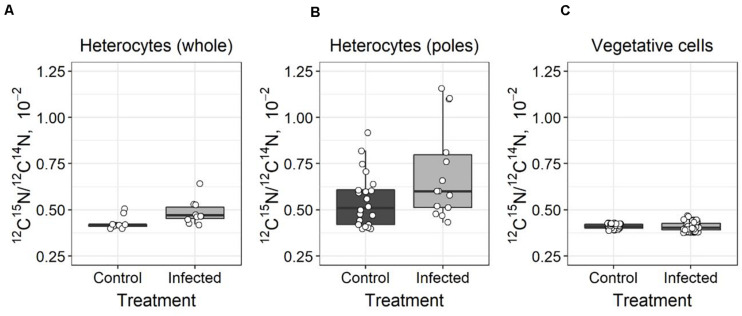
Differences in 15N enrichment in Aphanizomenon flos-aquae strain 2012/KM1/D3 heterocytes (whole cell–A, poles–B) and vegetative cells (C) indicated as 12C15N/12C14N ratio (calculated from nanoSIMS analysis). The solid line within the box marks the mean, the boundaries of the box represent the standard error, and the whiskers above and below the box show the standard deviation from the mean. White circles represent the data value of each measured heterocyte (A,B) or vegetative cell (C).